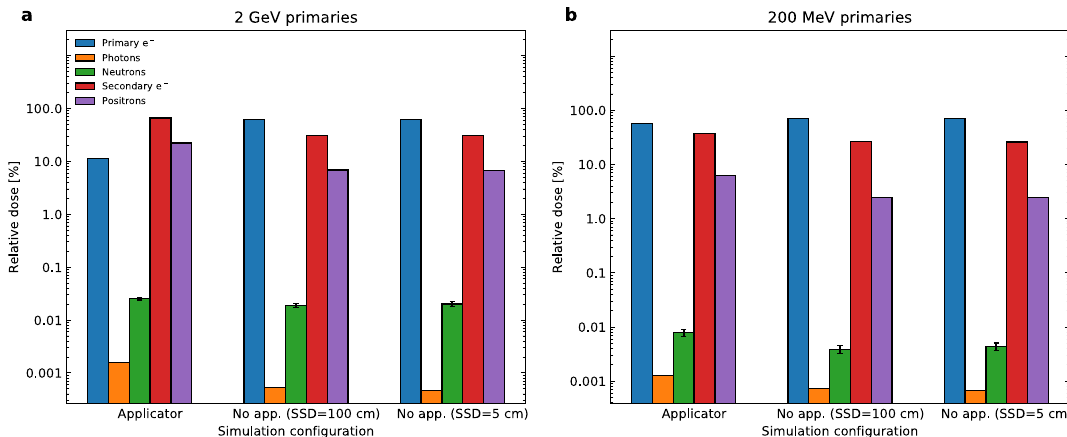
Figure 3. Absorbed dose contributions of secondaries to the target, as a percentage of the total target dose which was normalised to 2 Gy. Contributions of primary and secondary electrons, photons, neutrons and positrons were investigated for (a) 2 GeV and (b) 200 MeV primaries. The corresponding simulation configuration is given on the x-axis of each graph, and the percentage contribution to the 2 Gy total is given on the